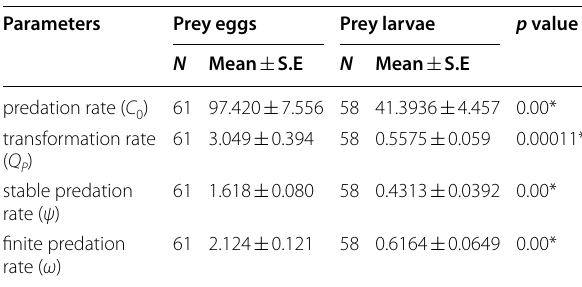
Table 5 Predation related parameters of Blattisocius mali fed on eggs and larvae of T. putrescentiae